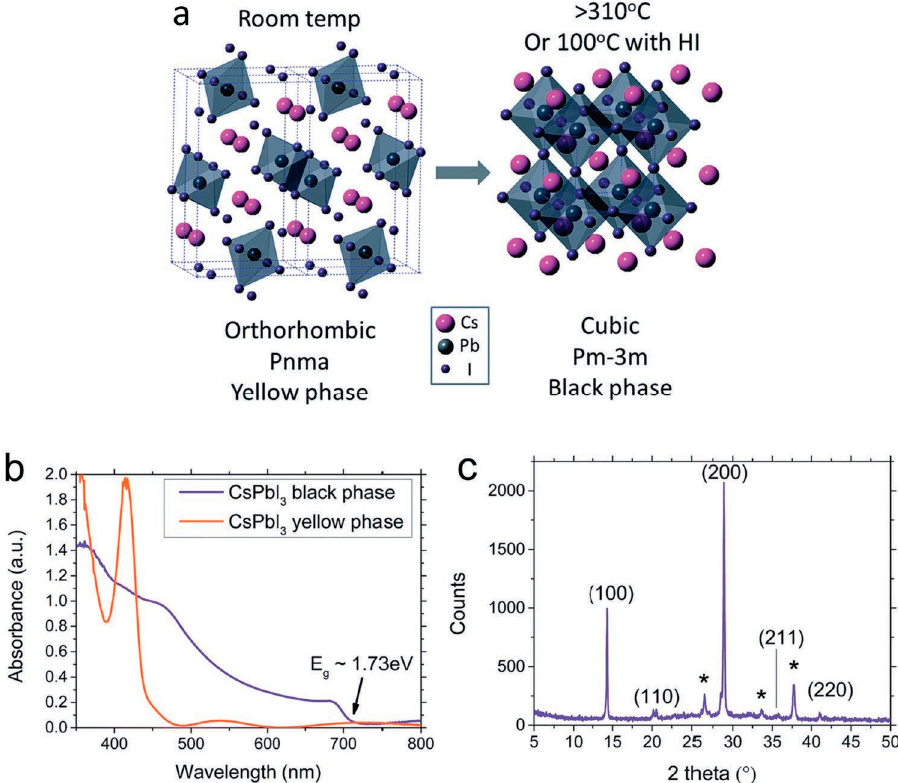
Figure 1. Different phases of CsPbI 3 all-inorganic perovskite material. ( a ) Lattice structure of orthorhombic yellow ( δ ) phase and cubic black ( α ) phase of CsPbI 3 ; ( b ) Visible-ultraviolet spectra of yellow and black phased CsPbI 3 film; ( c ) XRD of black phased CsPbI 3 film. The peaks correspond to cubic phase lattice having a = 6.1769(3) Å. The peaks shown by “*” denote the fluorine-doped tin xxide (FTO) substrate. Adapted with permission from [36].